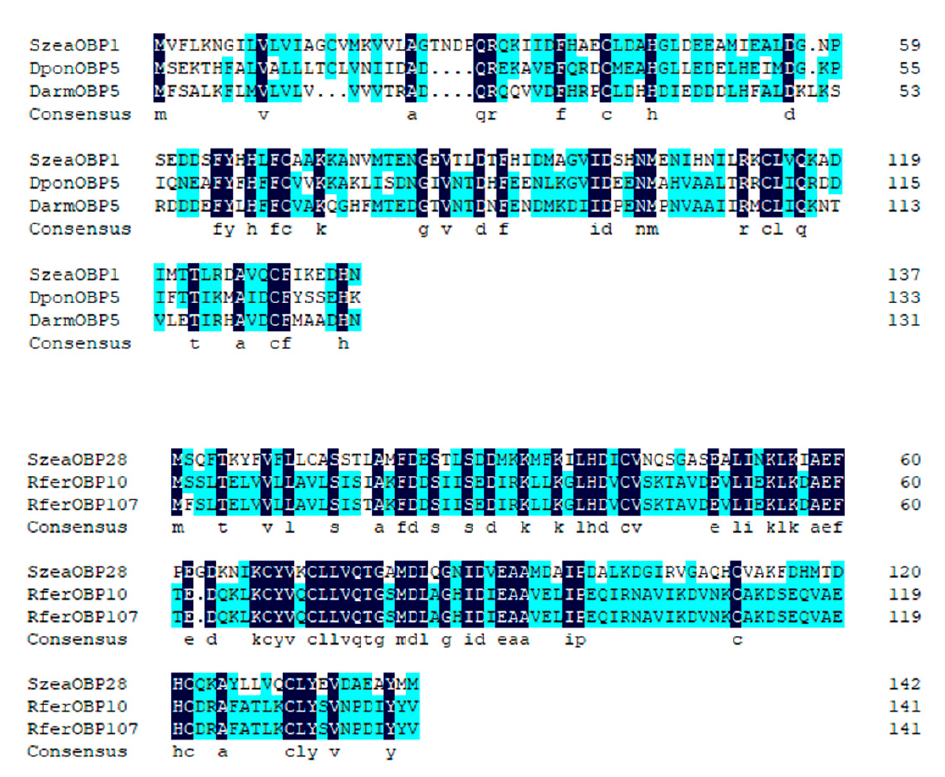
Figure 2. Multiple sequence alignment of OBPs from Sitophilus zeamais and other Coleoptera insects. The species names and GenBank accession numbers of the four OBPs are as follows: Dendroctonus